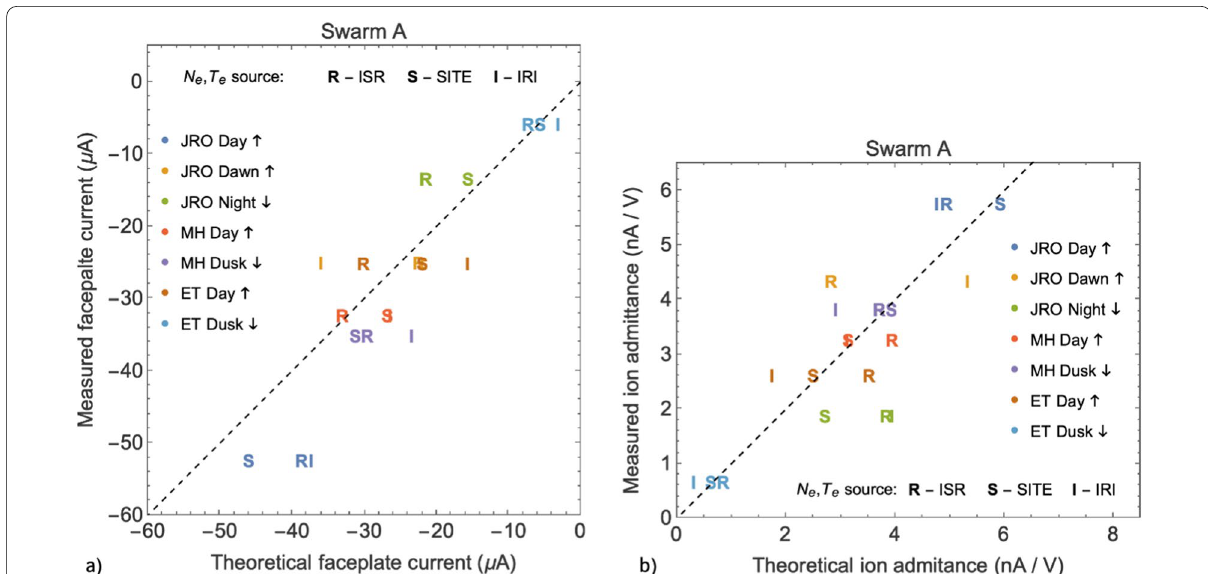
Fig. 9 Incoherent scatter radar facility validation. a Measured faceplate current vs theoretical current for each radar facility and for each of three estimates used for electron density and temperature. Ion composition was estimated using the IRI in all cases. b Measured vs theoretical ion admittance. Theoretical values include adjustments based on PIC simulations from Resendiz Lira et al. (2019) and Resendiz Lira and Marchand (2021)